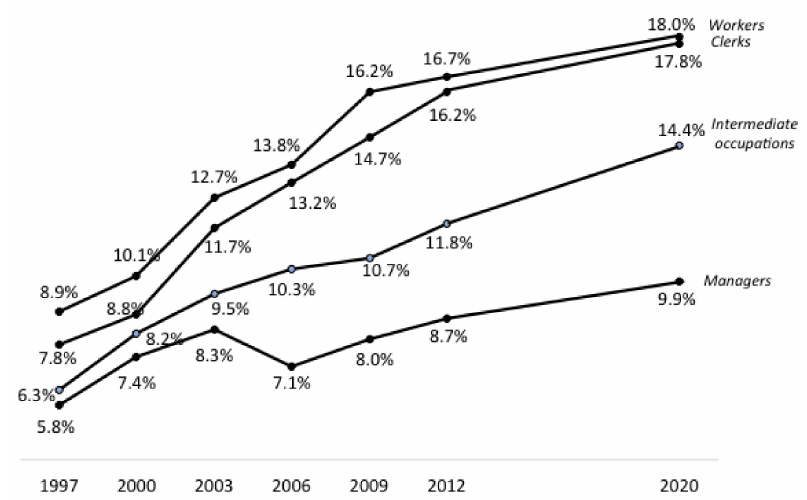
Figure 5. Evolution of the prevalence of obesity (BMI ≥ 30 kg/m 2 ) by professional category, Obepi- Roche 1997–2012 [8] with addition of LCO 2020 Obepi-Roche